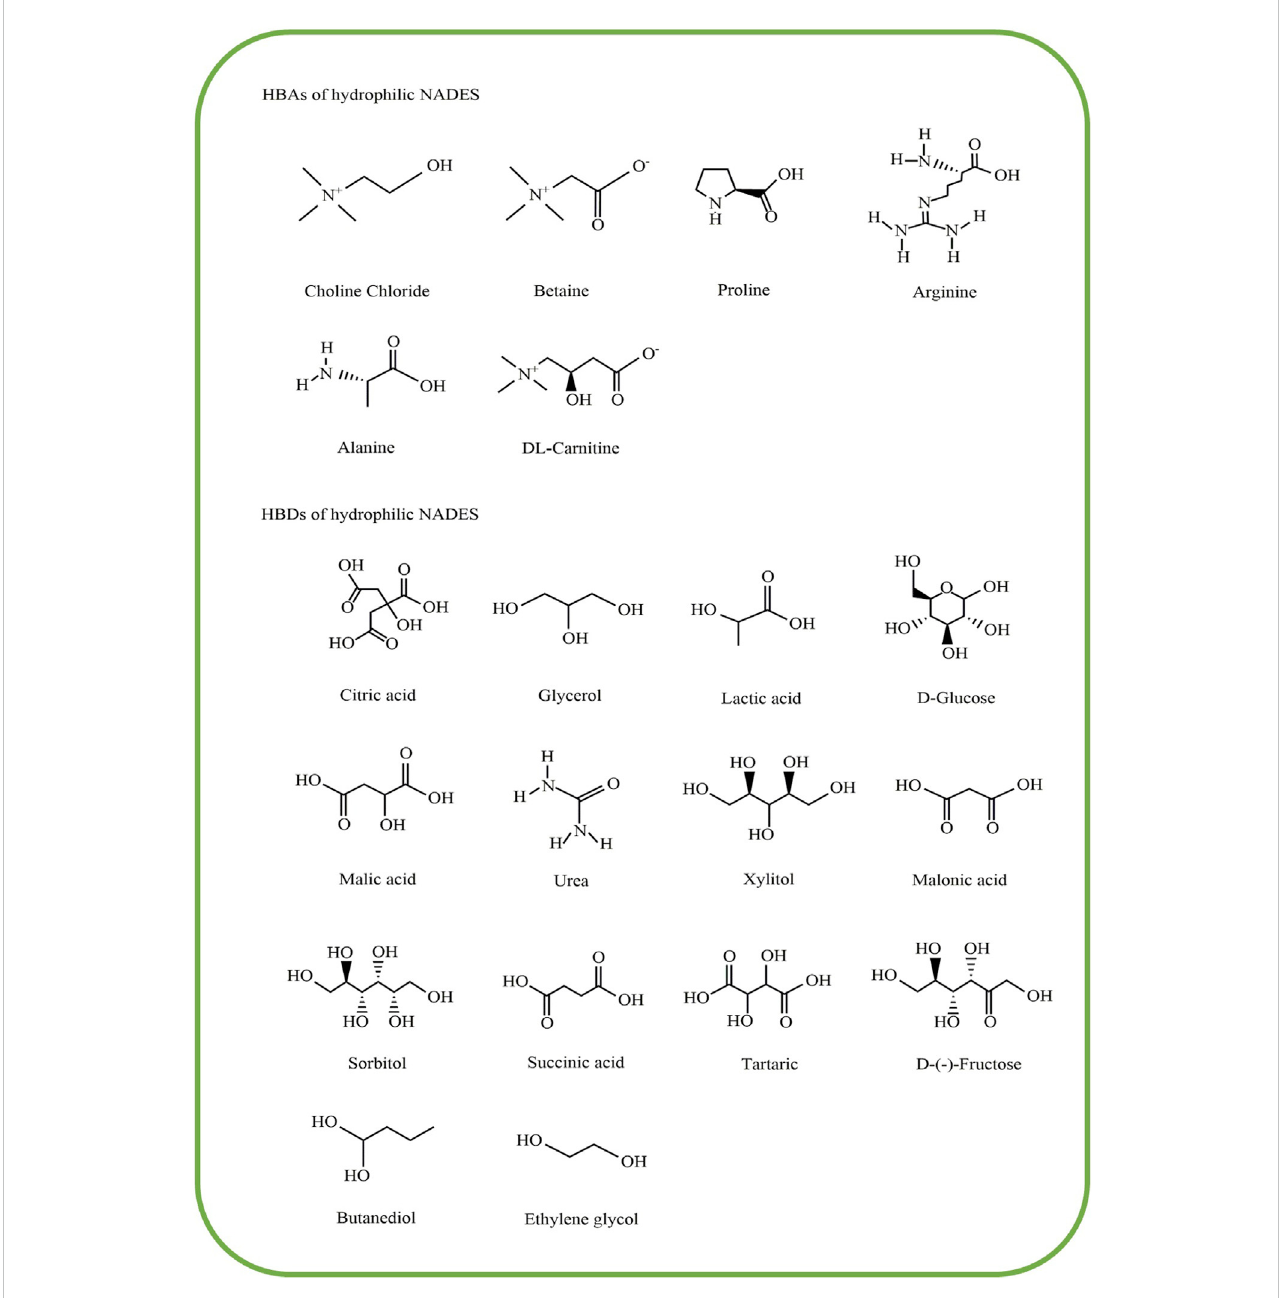
FIGURE 3 Common components of hydrophilic NADES. NADES, natural deep eutectic